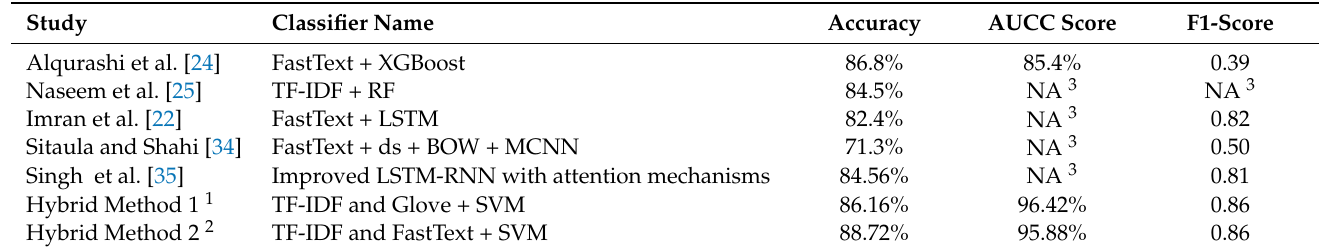
Table 5. Summary of the reviewed COVID-19